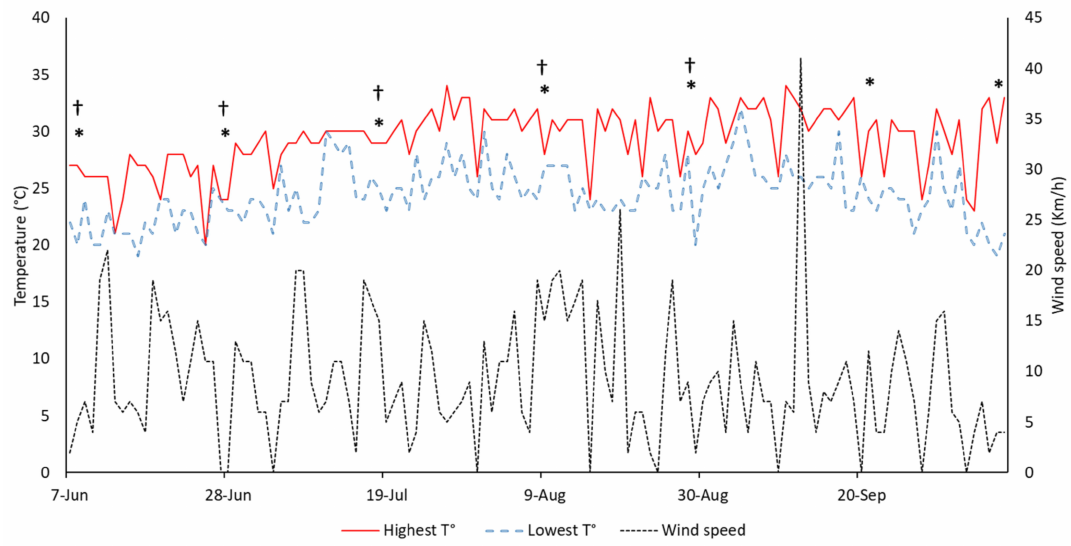
Figure 2. Meteorological parameters during the four-month sampling campaign. * denotes the sampling dates and † denotes pesticides’